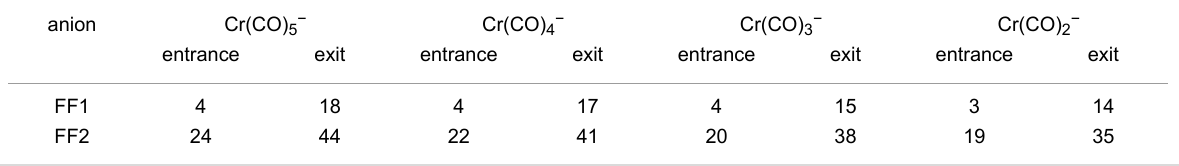
Table 2: Flight time in FF1 and FF2 for different anions (values in µs).